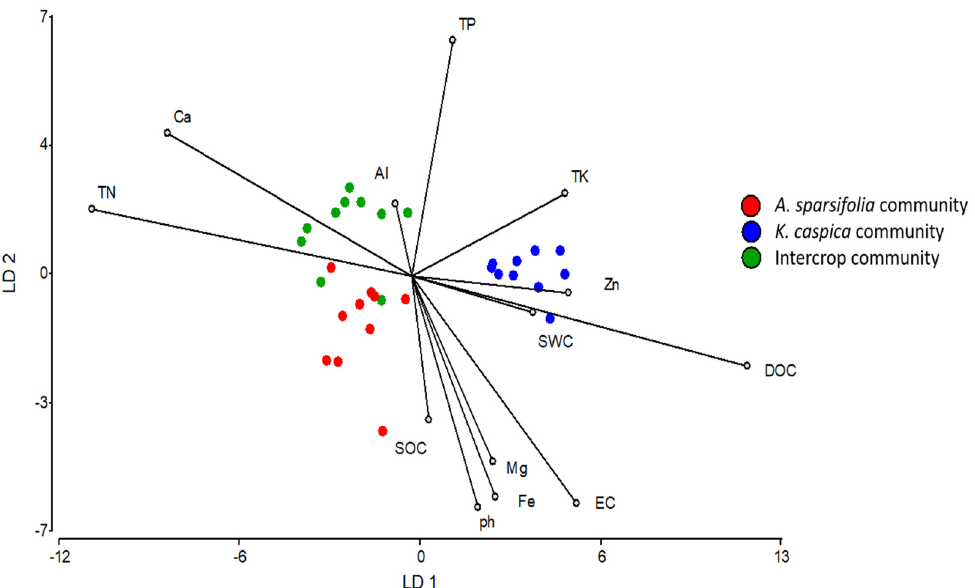
Figure 1. Relationships between soil physicochemical properties and plant communities, as determined by lineal discriminant analysis (LDA). Different colored dots represent different plant communities ( Alhagi sparsifolia (legume) monoculture, Karelinia caspia (non-legume) monoculture, and both species intercropped). DOC, dissolved organic carbon (C); SOC, soil organic C; TN, total nitrogen (N); TP, total phosphorus (P); TK, total potassium (K); Ca, calcium; Mg, magnesium; Fe, iron;